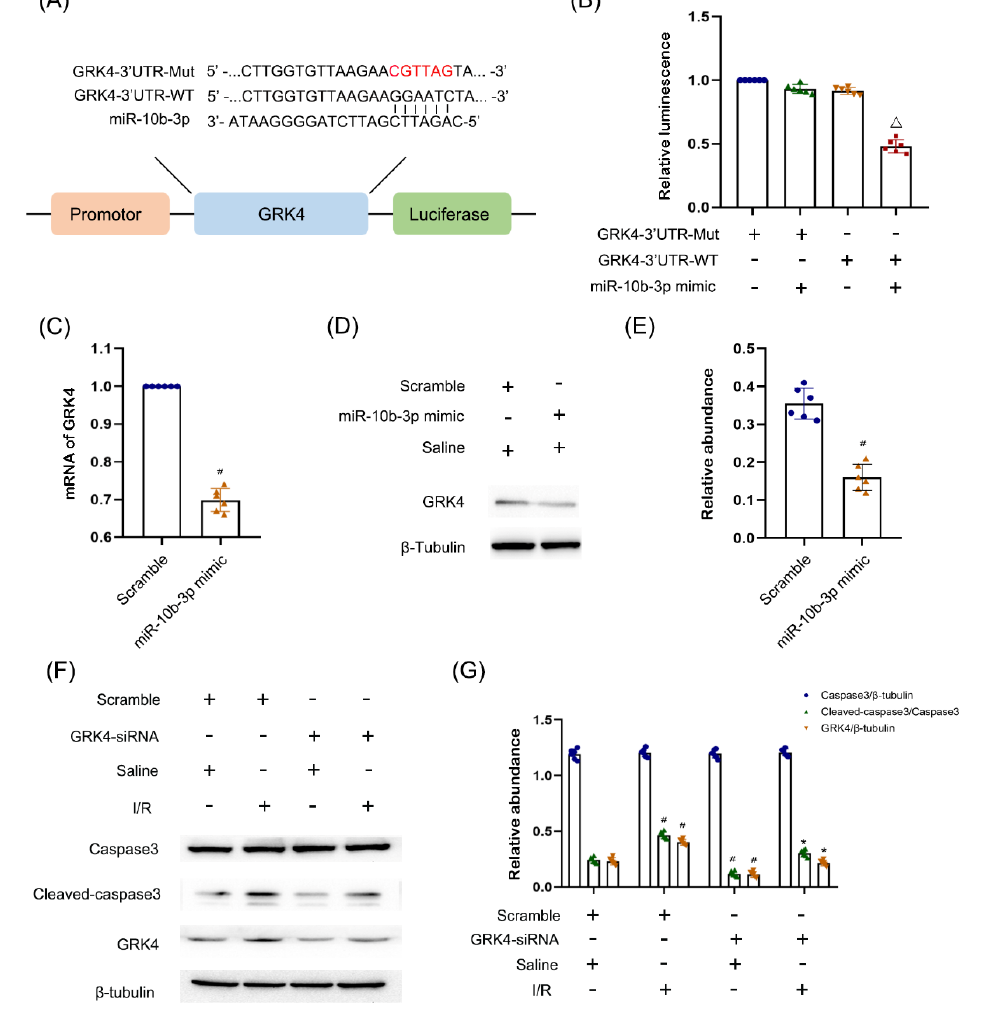
Figure 6. GRK4 was a direct target gene of miRNA − 10b − 3p . BUMPT cells were transfected with 100 nM miRNA − 10b − 3pmimics plus with or without GRK4 − WT or Mut plasmid for 24 h. BUMPT cells were transfected with GRK4 siRNA, and then treated with I(2 h)/R(2 h) injury. ( A ) Representative miR − 10b − 3p complementary binding sites or mutated sequence in the 3 (cid:48) UTR of GRK4 mRNA. ( B ) Representative the luciferase activities. ( C ) RT − qPCR analysis of the expres- sion of GRK4. ( D ) Immunoblot analysis of GRK4 and β − tubulin. ( E ) The gray analysis between them. ( F ) Immunoblot analysis of Cleaved − caspase3, Caspase3, GRK4, and β -tubulin. ( G ) The gray analysis between them. Data are expressed as mean ± SD ( n = 6). ∆ p < 0.05 vs. co-transfection of miR − 10b − 3p mimic and GRK4-3 (cid:48) UTR-WT or GRK4-3 (cid:48) UTR-MUT groups, # p < 0.05 vs. saline with scramble group; * p < 0.05 vs. I/R with scramble